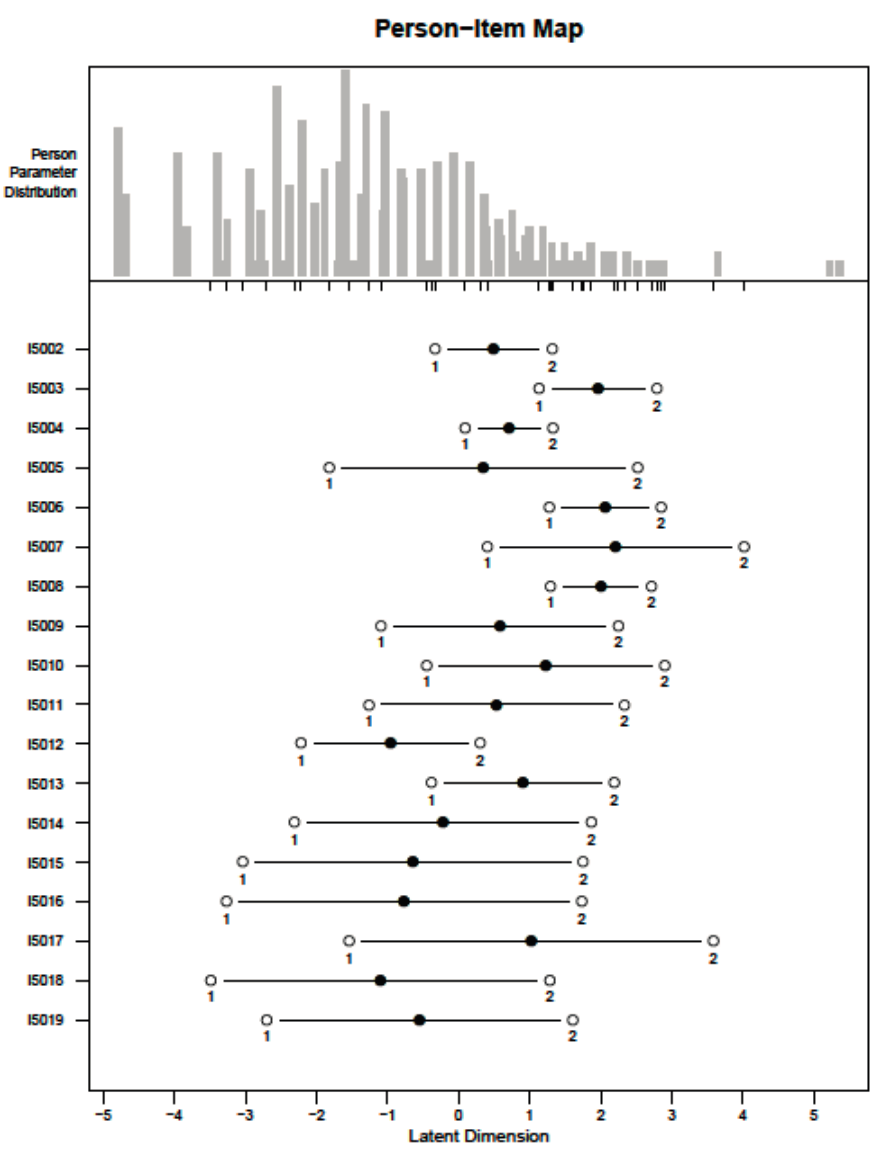
Figure 1. Person-item map of the capacity metric built with Rasch